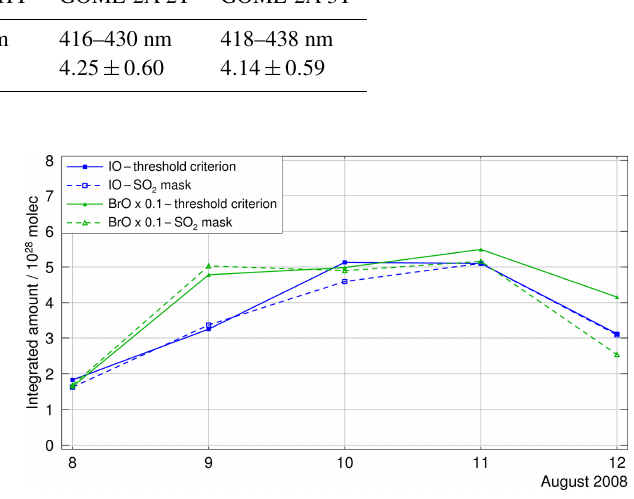
Figure 4. Time series of integrated IO (blue) and BrO (green) amounts. BrO data is scaled by a factor of 0.1. For both trace gases, two methods for the plume definition are applied, the threshold cri- terion and the SO 2